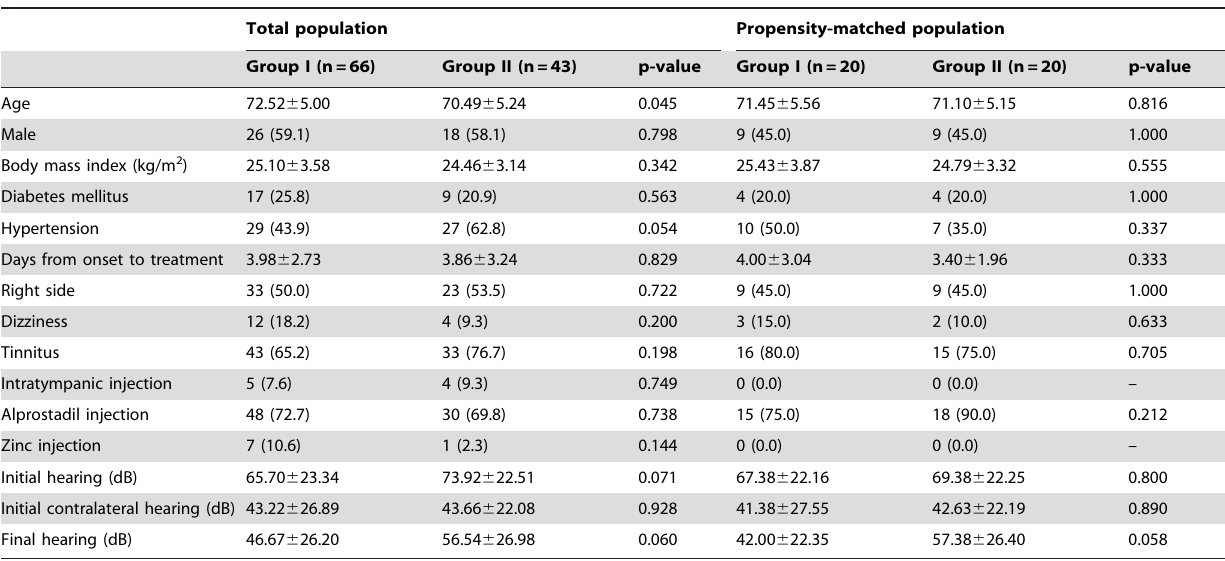
Table 1. Baseline clinical